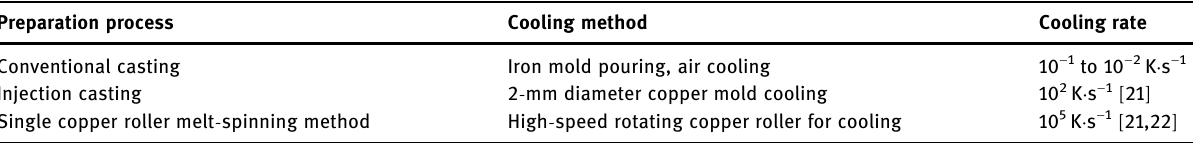
Table 1: Brief introduction of three preparation processes Preparation process